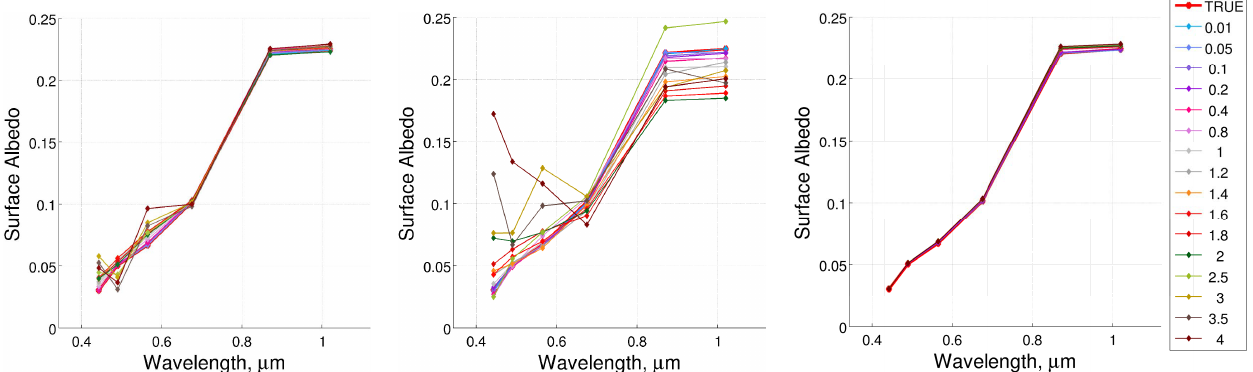
Fig. 11. Retrieval of surface albedo over Mongu for 16 different aerosol loadings from τ (0.44 µm)=0.01 to 4.0: (left panel) single-pixel retrieval with no noise added; (center panel) single-pixel retrieval with the random noise added; (right panel) multi-pixel retrieval with the random noise